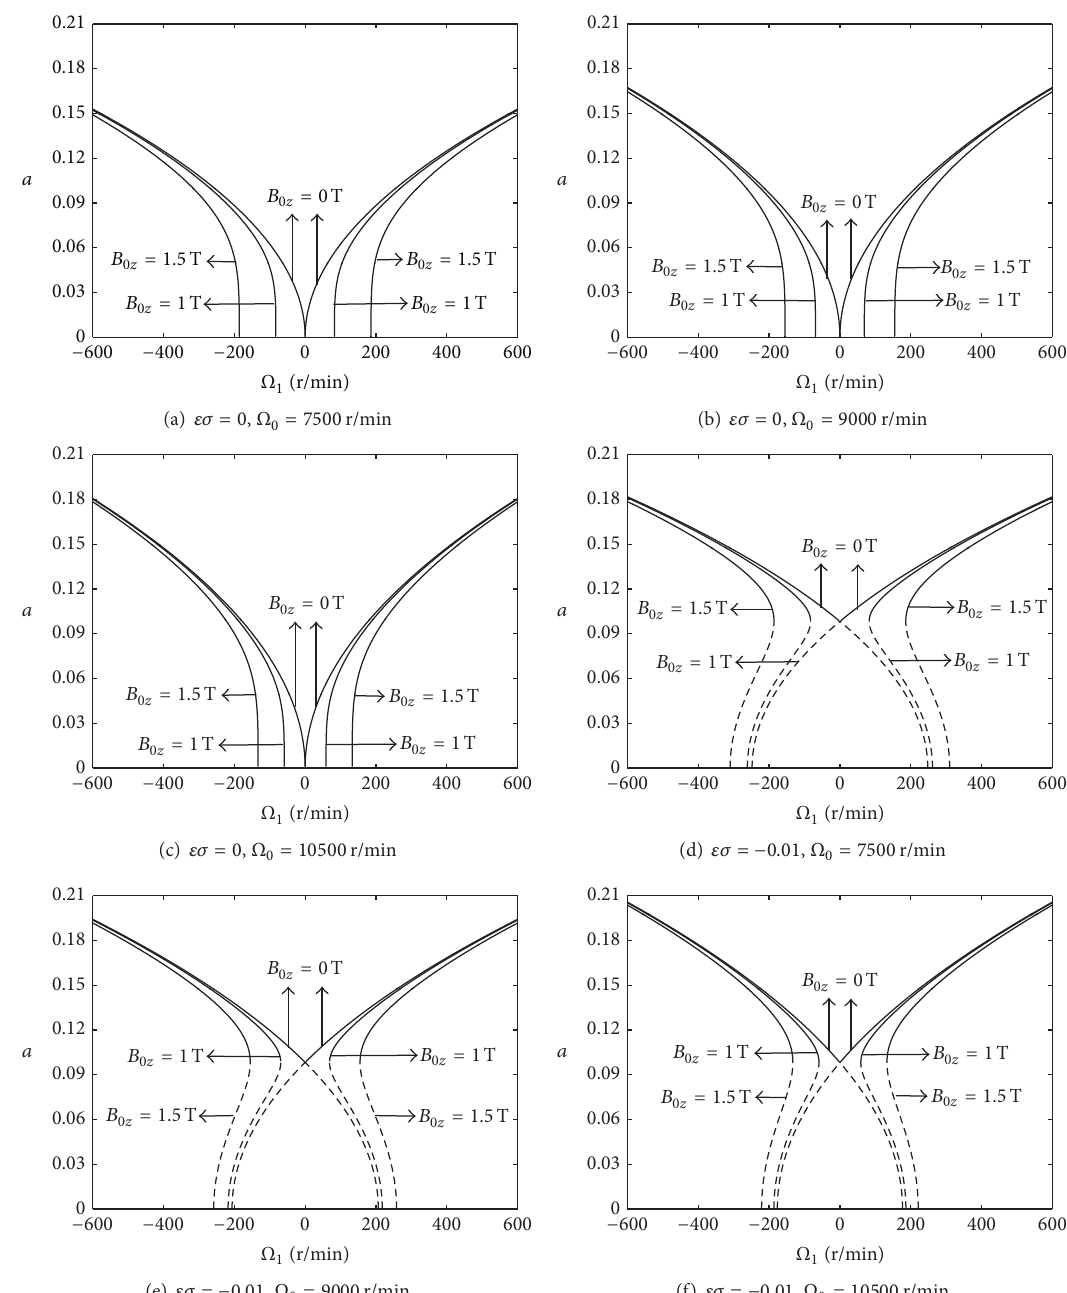
Figure 5: The characteristic curves of resonance amplitude-amplitude of velocity disturbance